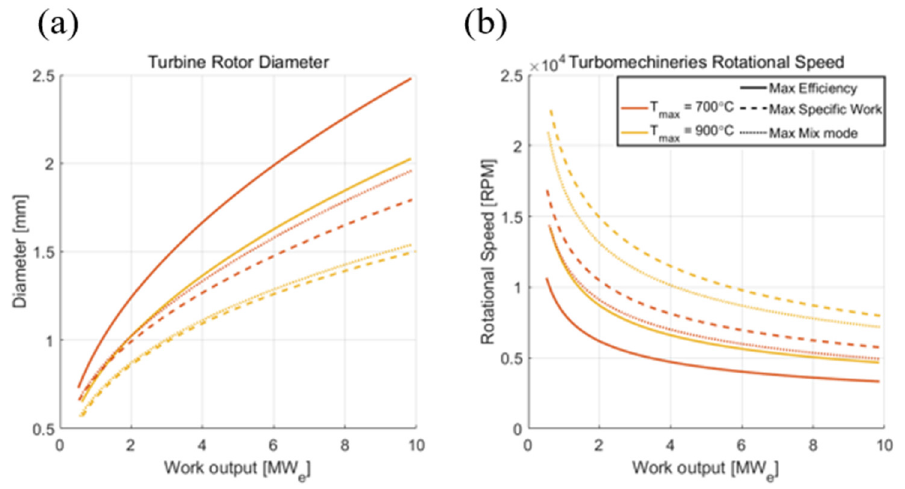
Figure 19. ( a ) Turbine rotor diameter and ( b ) turbomachinery rotational speed of open-air Brayton Cycle.